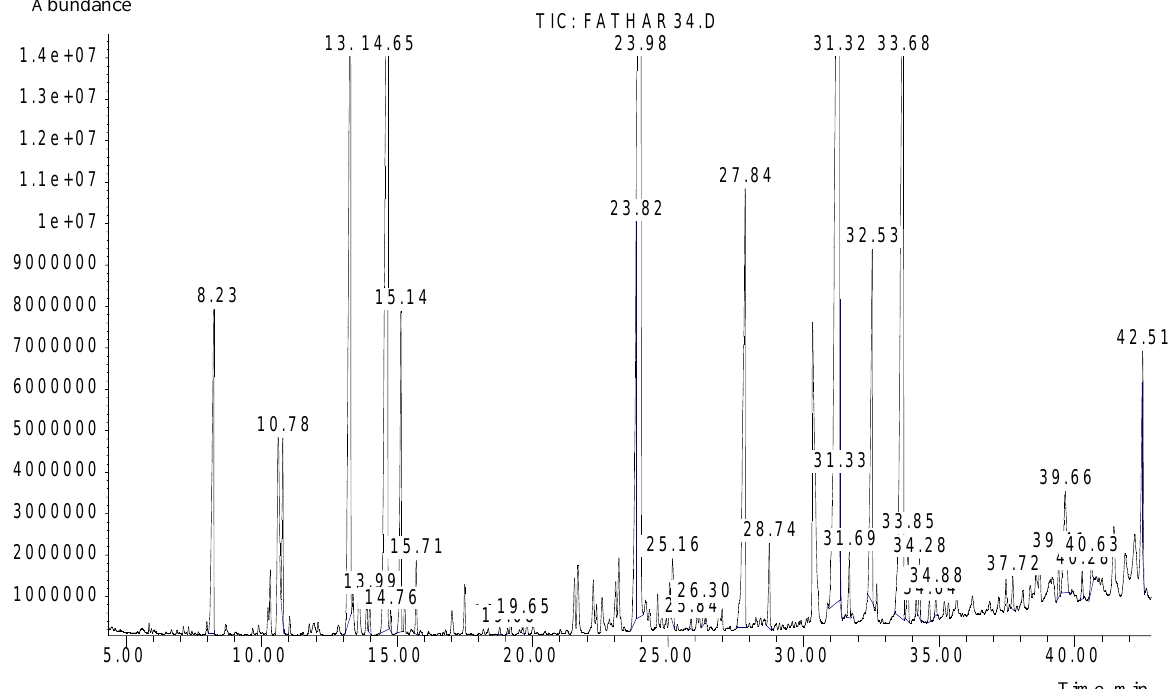
Fig. 3. Chromatographic profile of methyl esters of carboxylic acids of Veronica chamaedrys